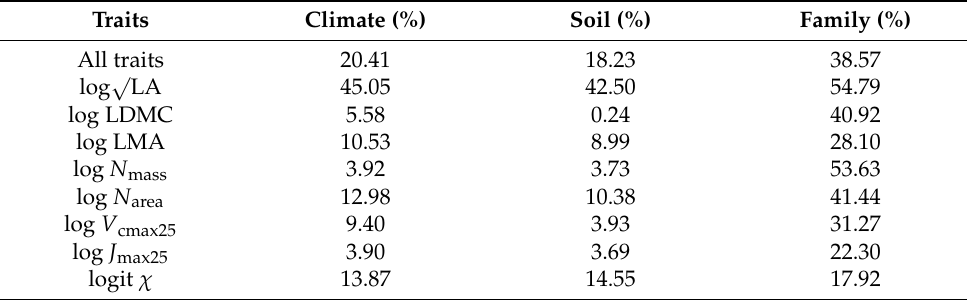
Figure 7. Contributions (%) of climate, soil and family to trait variations. The negative values can be treated as zero because all the values are adjusted correlation coefficients. LA: leaf area; N mass : leaf nitrogen content; N area : leaf nitrogen per area; LMA: leaf mass per area; LDMC: leaf dry mass content; V cmax25 : maximum carboxylation rate standardized to 25 ◦ C; J max25 : maximum electron transport rate standardized to 25 ◦ C; χ : ratio of intercellular to ambient CO 2 concentration. Table 3. Total contributions (%) of climate, soil and family to trait variations.